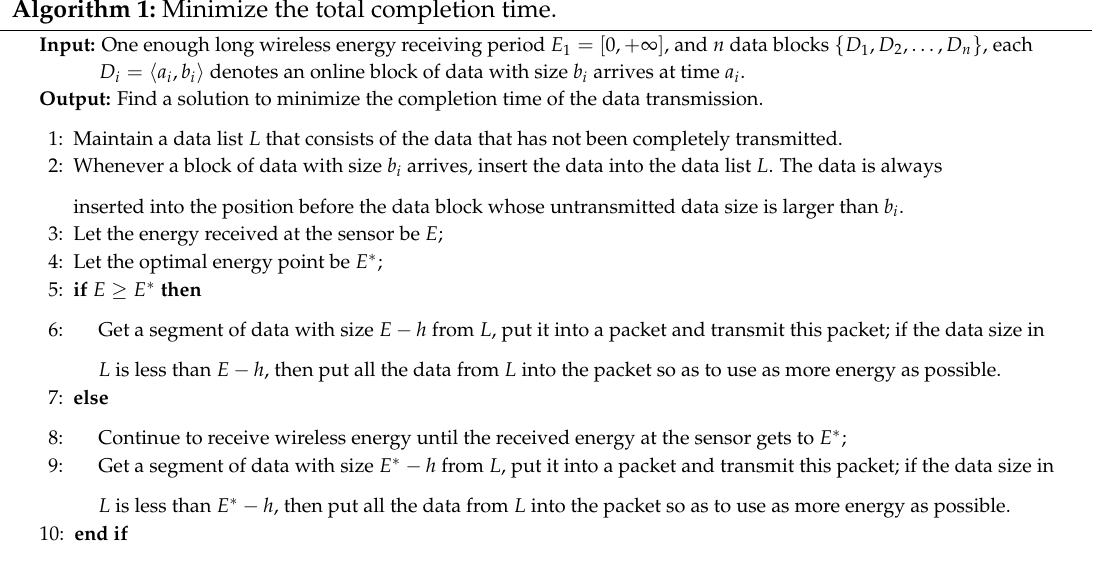
Algorithm 1: Minimize the total completion